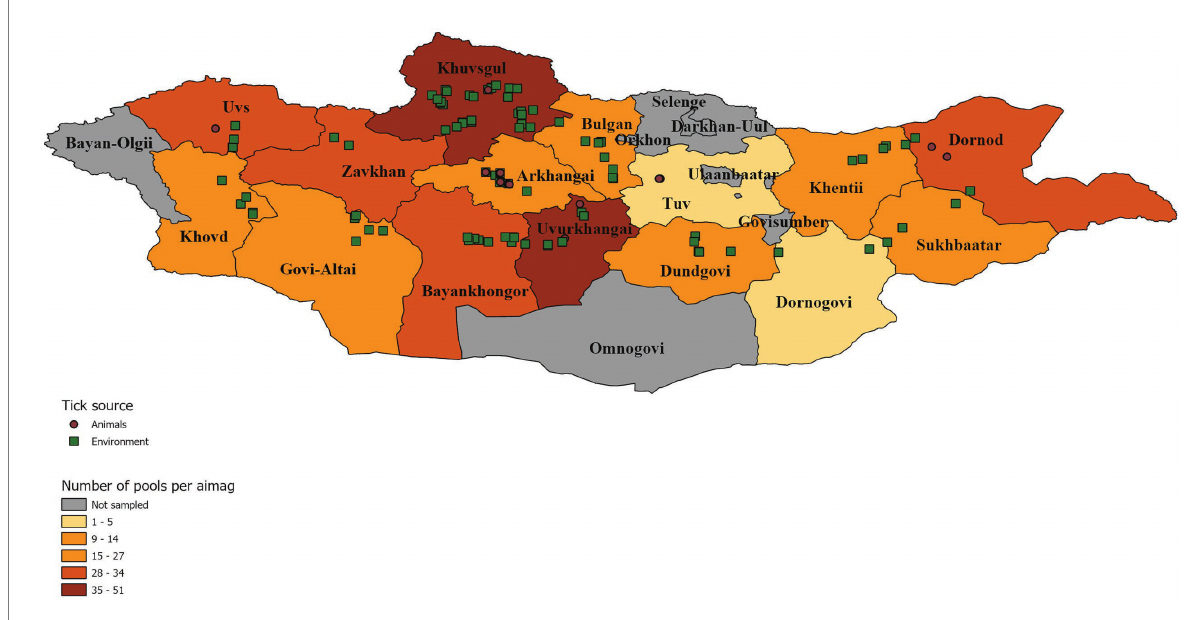
FIGURE 1 Distribution of tick collection events symbolized according to collection source. A map of Mongolia representing the location of tick pools that were chosen for further analysis. Tick pools are symbolized according to their collection source off animals (brown circle) or from the environment (green square). Individual aimags are colored according to the number of pools analyzed per aimag to demonstrate sampling intensity.